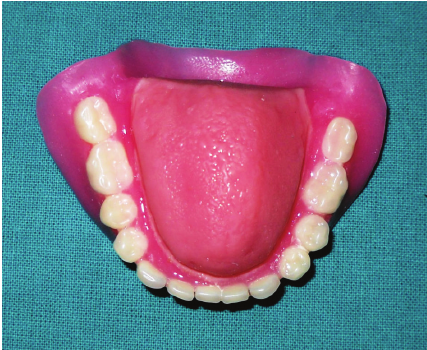
Figure 10: Final tongue